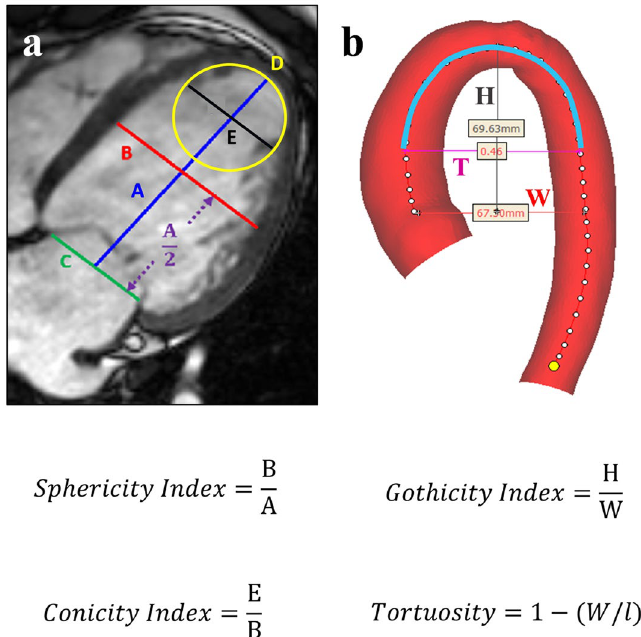
Figure 2. Morphometric measurements. ( a ) Calculation of LV sphericity as short (B) to long (A) axis ratio, with short axis set as the perpendicular intersect of the long axis mid-point (A/2) while long axis being the distance from the mitral valve mid-point (C) to apex, and calculation of LV conicity as apical (E) to short axis ratio, with apical axis being the diameter of the best fitting sphere (D) (calculations were taken directly on the scans). ( b ) Calculation of aortic gothicity as height to width ratio (H/W) [The aortic arch width was measured as the perpendicular distance from the centreline at the sinotubular junction level to the centreline at the mid-descending aorta. The height of the arch was measured as the maximum vertical distance from the width measurement to the highest point of the centreline in the arch], and aortic tortuosity as 1-(W/l) with l being the length of the aortic arch as shown by T (highlighted in blight-blue on the centreline). T shows the endpoints set to indicate the aortic arch defined by using the pulmonary artery as a landmark (calculation were taken using Mimics